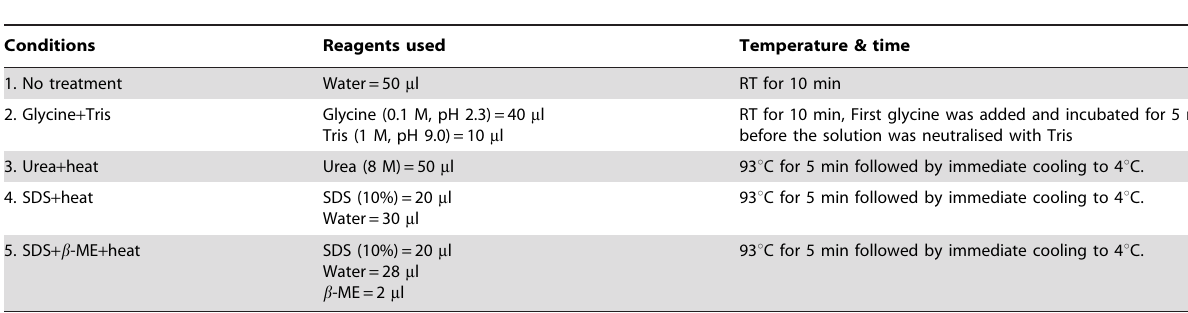
Table 1. Different processing conditions for simulated serum samples.